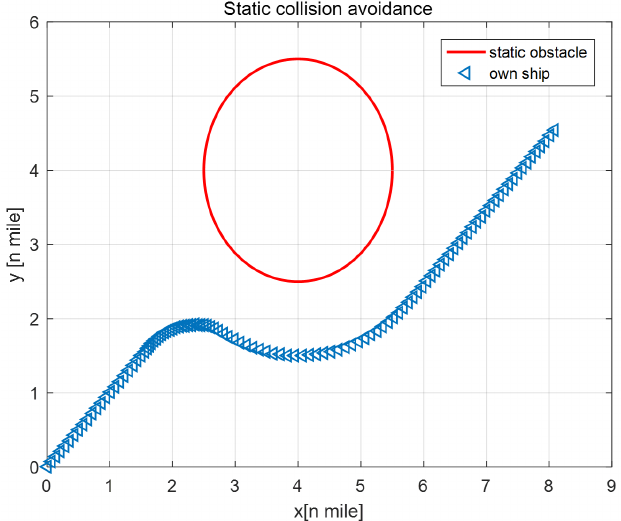
Figure 13. Trajectory of static collision